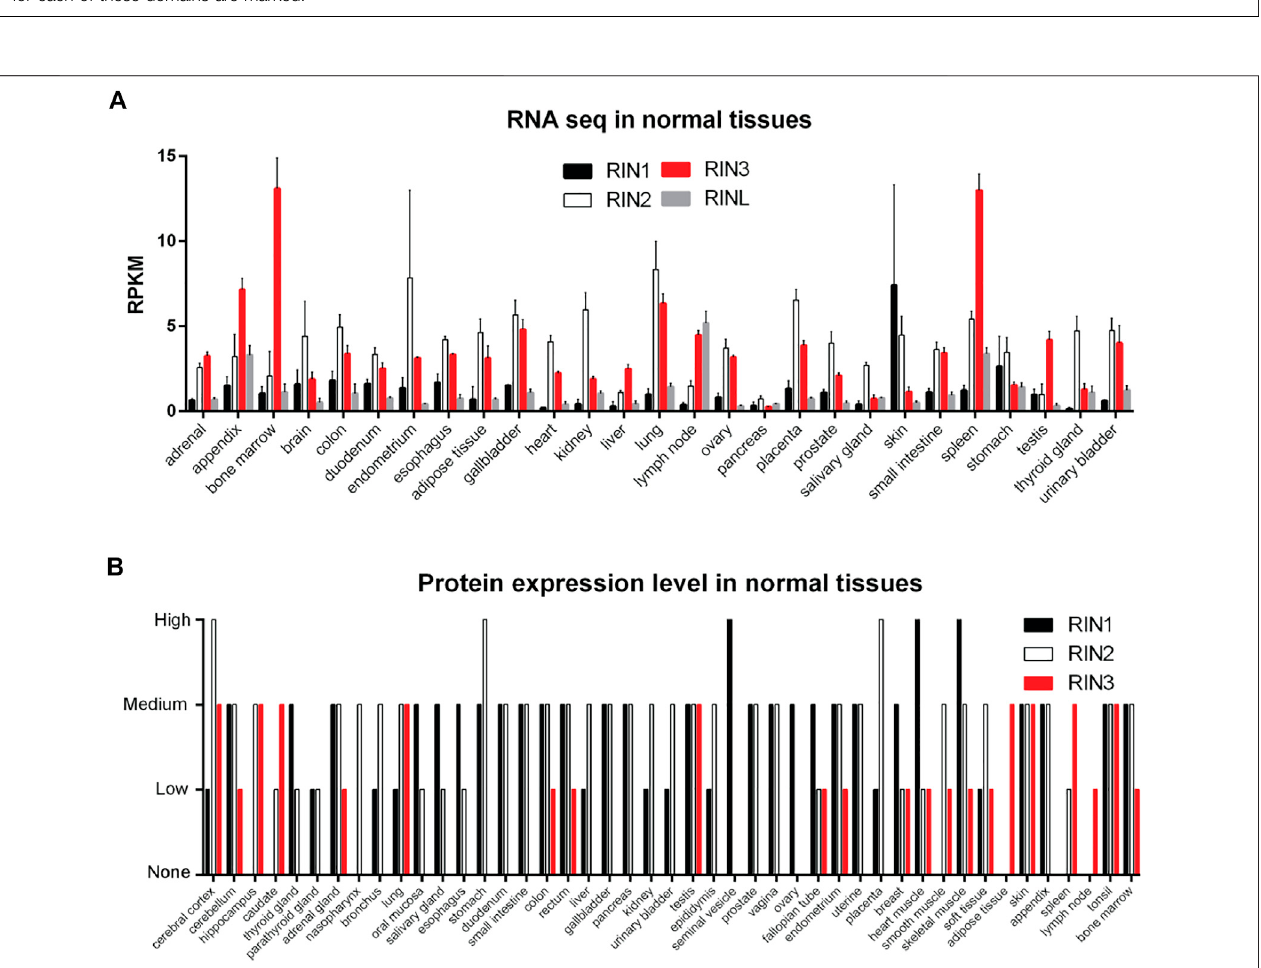
FIGURE 2 | Expression pro fi le of RIN family in normal human tissues. (A) : RNA levels of individual RIN genes. Data comes from HPA RNA-seq normal tissues project (Fagerberg et al., 2014). (B) : Protein expression level of RIN1/2/3. Data comes from the Human Protein Atlas (https://www.proteinatlas.org/).